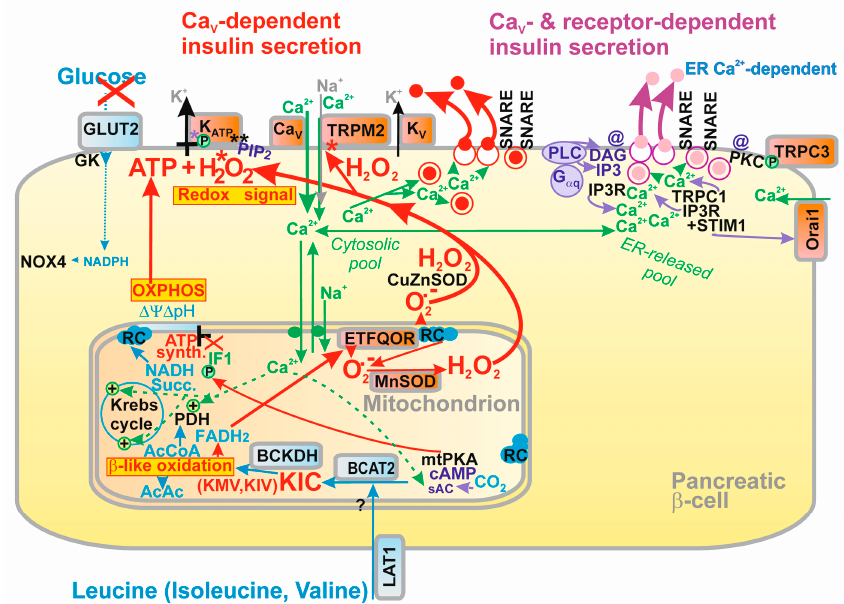
Figure 7. The mechanism of branched-chain keto acid-stimulated insulin secretion involves redox signaling of mitochondrial origin. 2-ketoisocaproate (KIC), 2-ketomethylvalerate (KMV) and 2-ketoisovalerate (KIV) resulting from leucine, isoleucine and valine (imported into cells by the plasma membrane LAT1 transporter), respectively, due to the branched-chain aminotransferase reaction in the mitochondrial matrix (BCAT2), are metabolized by branched-chain ketoacid dehydrogenase (BCKDH), both existing exclusively in the mitochondria of β -cells. A series of reaction of β -like oxidation begins at the dehydrogenase step, yielding FADH 2 . This dehydrogenase cofactor is reoxidized by the ETF, as a single electron carrier, from which ETFQOR accepts electrons and converts Q to QH 2 . As a side reaction, superoxide is formed by the respiratory chain or even within the ETFQR. In the mitochondrial matrix, superoxide is transformed to H 2 O 2 by MnSOD, whereas by CuZnSOD in the intermembrane space and cytosol. The elevated mitochondrial/cytosolic H 2 O 2 substitutes the redox signaling of the NOX4 origin. Consequently, such redox signaling, together with elevated ATP, sets the triggering conditions for insulin secretion. Either both H 2 O 2 and ATP evoke the K ATP closure (and TRPM2 is independently activated by H 2 O 2 ), or K ATP closing is “classically” ensured by the elevated ATP, while H 2 O 2 activates TRPM2 or other NSCCs provide the essential NSCC-mediated shift to the threshold depolarization. As a result, Ca V channels are open, providing the Ca 2+ signal for IGV exocytosis. The end products of the β -like oxidation of KIC, contributing to OXPHOS, are acetoacetate (AcAc) and acetyl-CoA (AcCoA). AcCoA enters the Krebs cycle to form citrate. AcAc can be partly exported to the cytosol or is converted to β -hydroxybutyrate by a reverse reaction of β -hydroxybutyrate dehydrogenase at the expense of NADH. Moreover, since theoretically the amplifying mechanism should remain intact, we predict that also the net (experimental) ketoacid-stimulated insulin secretion should be amplified by GLP1 and GIP (see Figure 2).